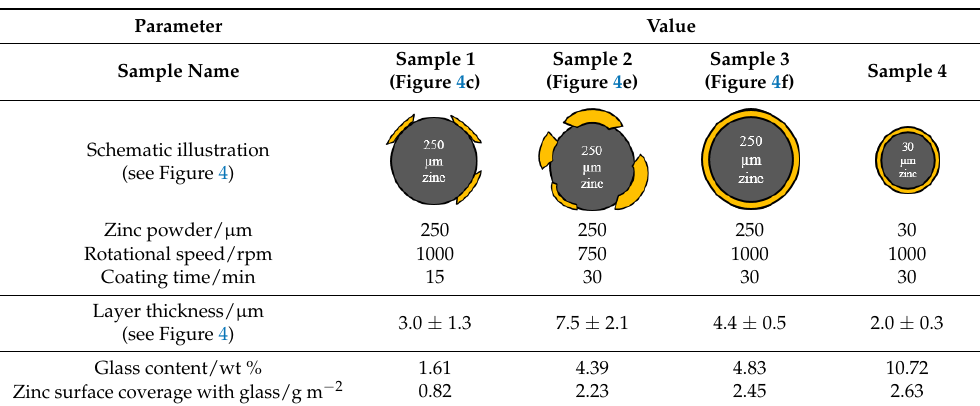
Table 2. Overview of electrochemically investigated zinc–glass composites with coating conditions and coating quality